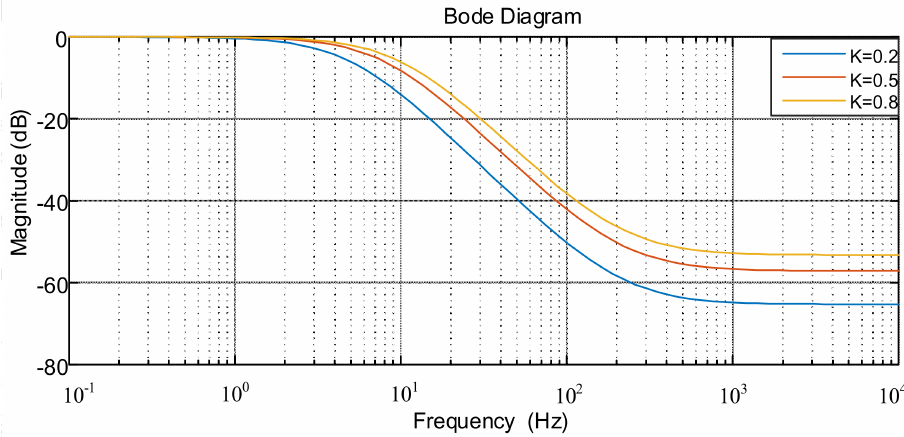
Figure 2. Frequency characteristic with different K (input: T L , output: ˆ T L